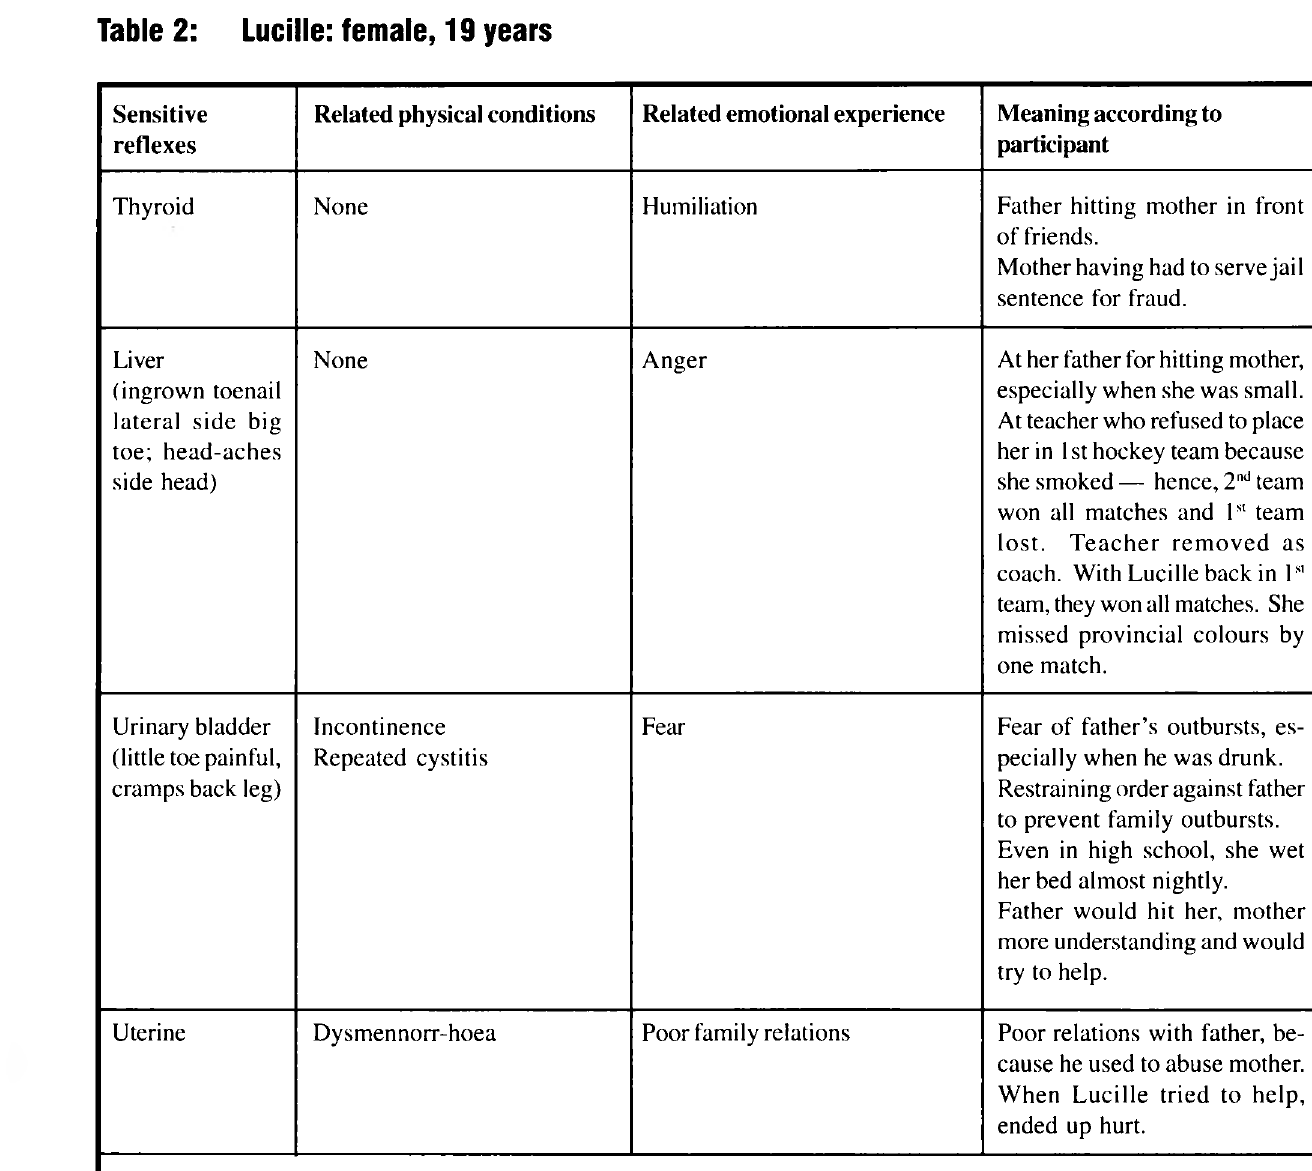
Table 2: Lucille: female, 19